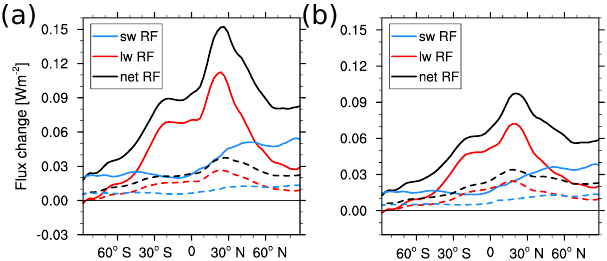
integrated up to 200hPa (in Tg). 3